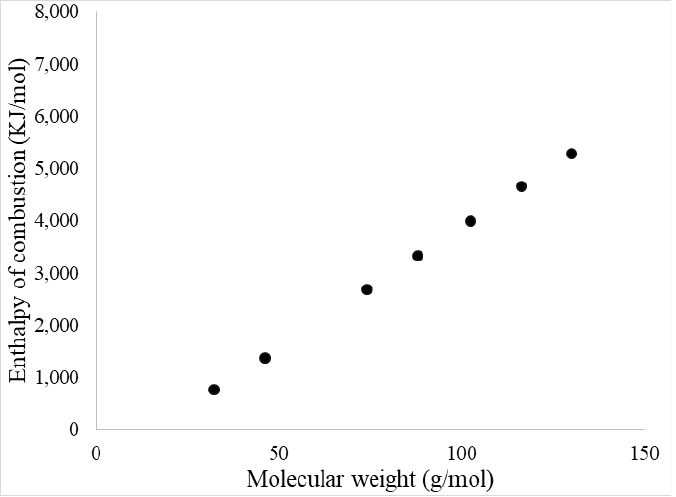
Figure 15. The effect of molecular weight of alcohols on enthalpy of combustion .